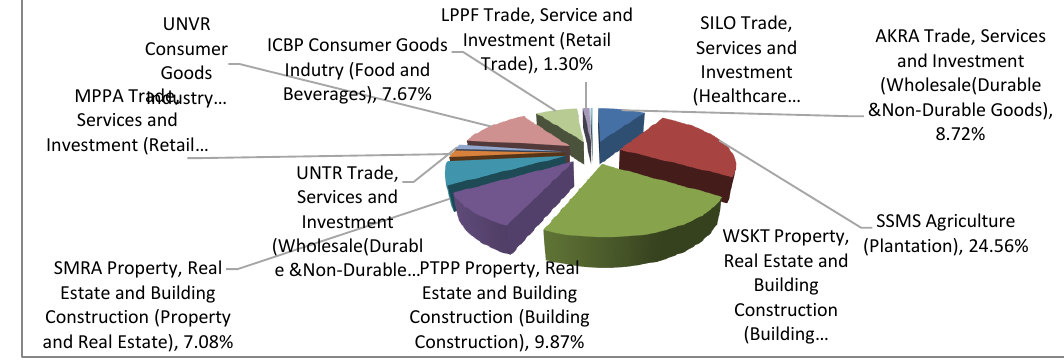
Figure 8 Semester 2 2015 Portfolio Percentage